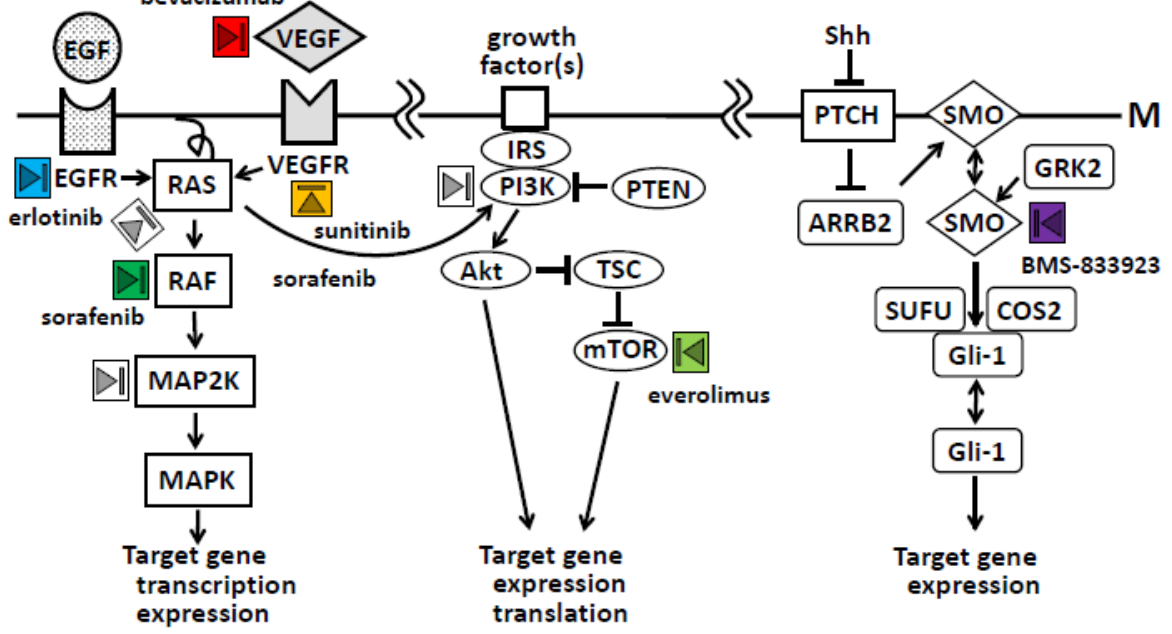
Figure 2. Critical molecular pathways leading to the development and progression of pancreatic cancer. Abbreviations: ARRB2, arrestin  2 ; COS2, kinesin-related protein Costal 2; DUSP6, dual specificity phosphatase 6; EGF, epidermal growth factor; EGFR, EGF receptor; GRK2, G protein-coupled receptor kinase-2; IRS, insulin receptor substrate 1; M, cell membrane; MAPK, mitogen-activated protein kinase; MAP2K, MAP kinase kinases; mTOR, mammalian target of rapamycin; PI3K, phosphatidylinositol 3-kinase; PTCH, patched; PTEN, phosphatase and tensin homolog deleted in chromosome 10; Shh, sonic hedgehog; SMO, smoothened; SUFU, suppressor of fused; TSC, tuberous sclerosis complex; VEGF, vascular endothelial growth factor; VEGFR, VEGF receptor. The gray triangle in a box indicates a target for drug